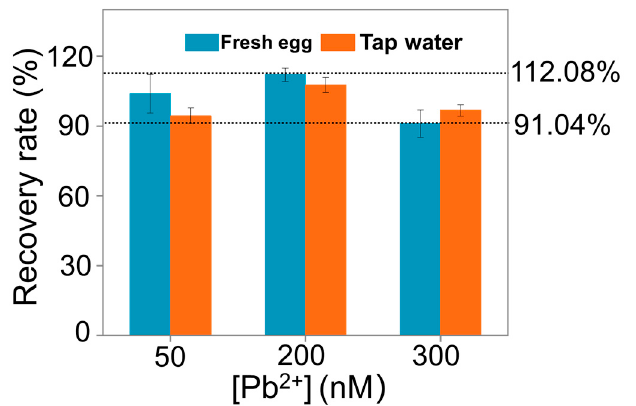
Figure 6. Application of the ratiometric fluorescent aptasensor. 50, 200, 300 nM Pb 2+ were spiked into the actual samples to verify the practicability of the ratiometric fluorescent